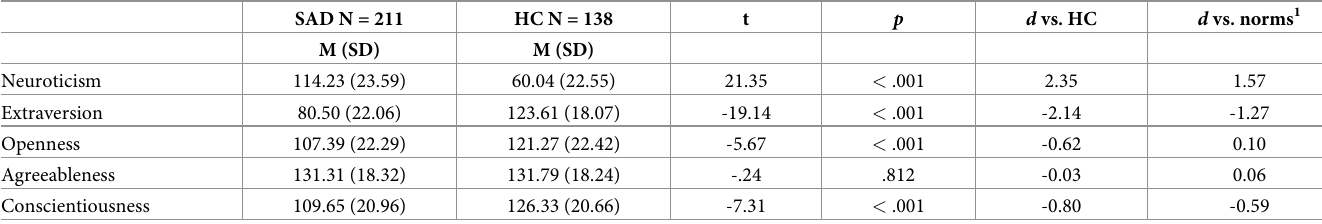
Table 1. Comparisons of social anxiety disorder (SAD) patients and healthy controls (HC) on NEO-PI-R Big Five dimensions.